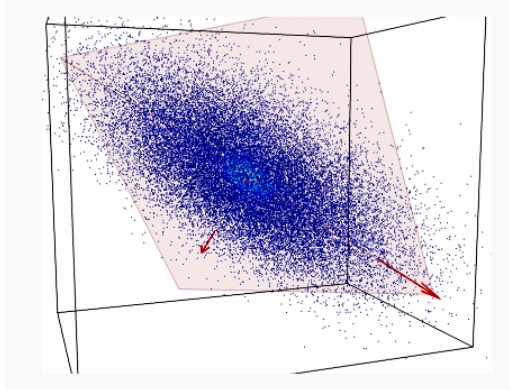
Figure 2. A set of data (blue dots) of three variables is represented into a 3D space. Data are mostly spread on the orange plane, with little departure from it. Principle component analysis (PCA) identifies the plane and the directions of maximum variability of data within it.